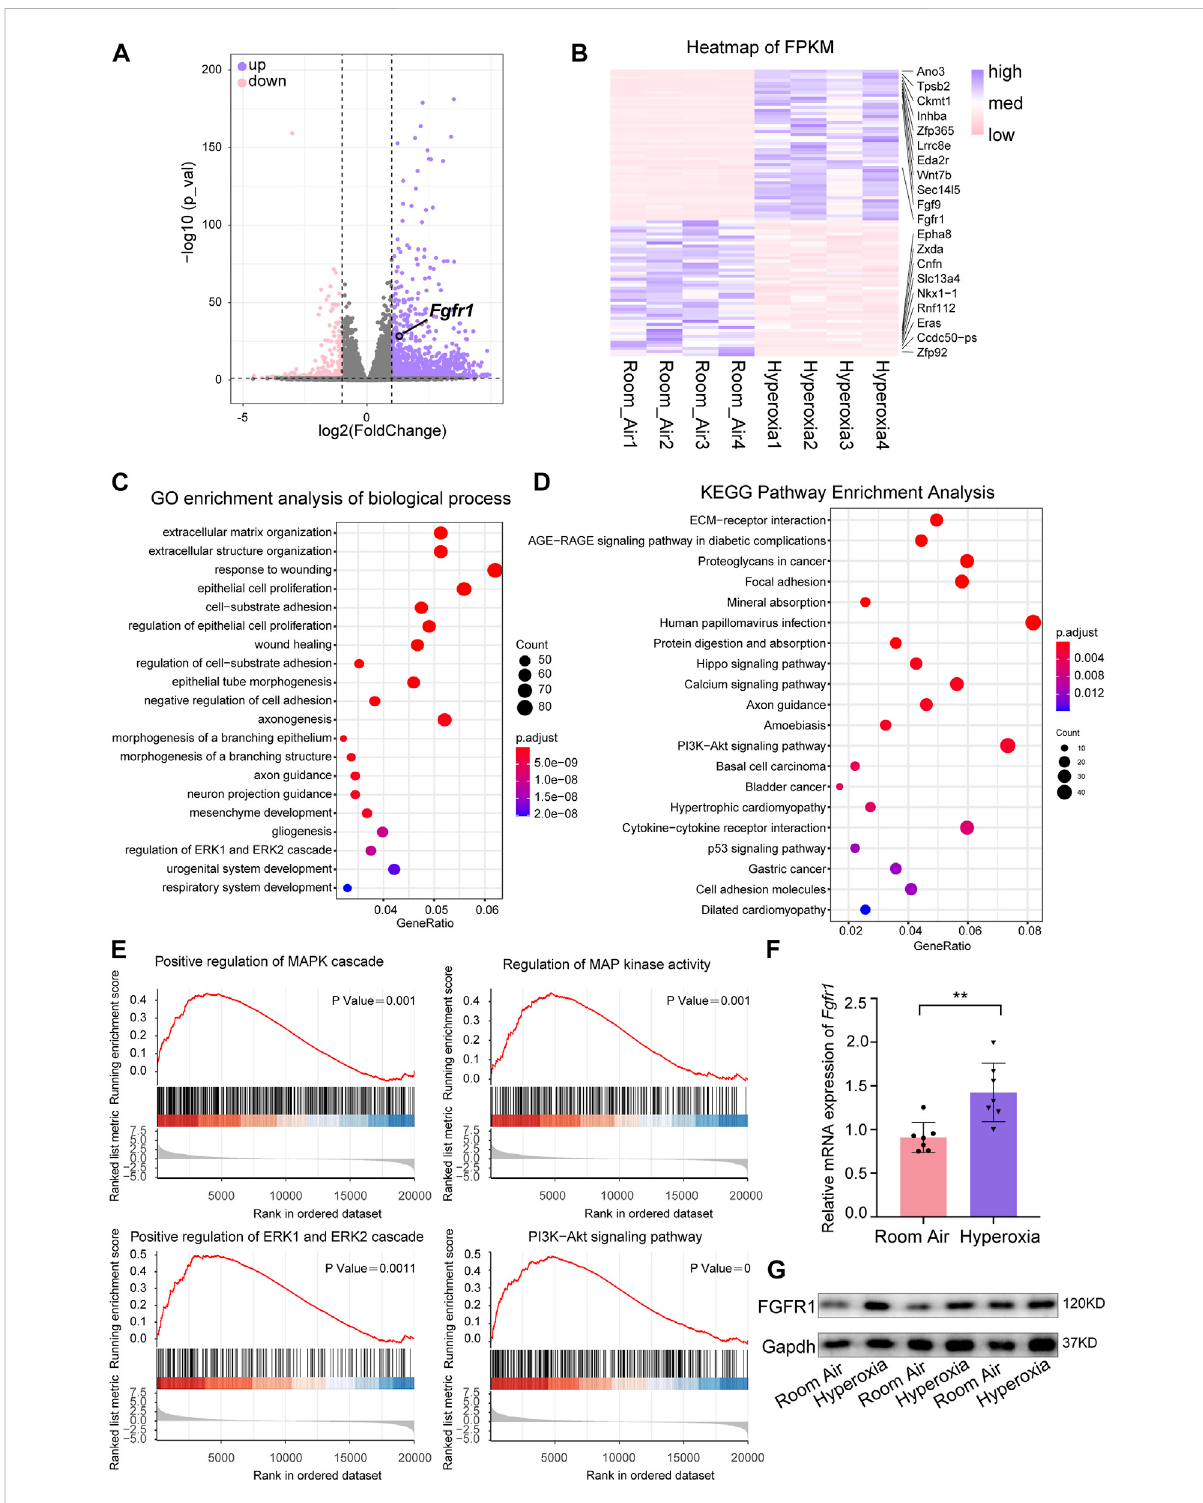
RNA-seq analysis of differentially expressed genes (DEGs) and hyperoxia-impacted signaling pathways in ECs from normal and hyperoxia- impaired lungs. (A) Volcano plot showing upregulated and downregulated transcript levels of DEGs, p-value < 0.05, |log2FoldChange| ≥ 1. (B) Heatmap of the top 50 upregulated DEGs and top 50 downregulated DEGs. (C) Hyperoxia-impacted signaling pathways in ECs as identi fi ed by GO enrichment analysis of biological processes. All terms shown are signi fi cantly enriched (p-value < 0.05). (D) Hyperoxia-impacted signaling pathways in ECs as identi fi ed by KEGG pathway enrichment analysis. All terms shown are signi fi cantly enriched (p-value < 0.05). (E) Upregulated downstream pathways of activated FGFR1 as revealed by Gene Set Enrichment Analysis, all terms shown are signi fi cantly enriched (p-value < 0.05). (F) qPCR of Fgfr1 expression in ECs of normoxic or hyperoxic lungs. n = 7 per group. Data are shown as means ± SEMs. ** p < 0.01. (G) Western blot examining the expression of FGFR1 in ECs of normoxic or hyperoxic lung, Gapdh as negative